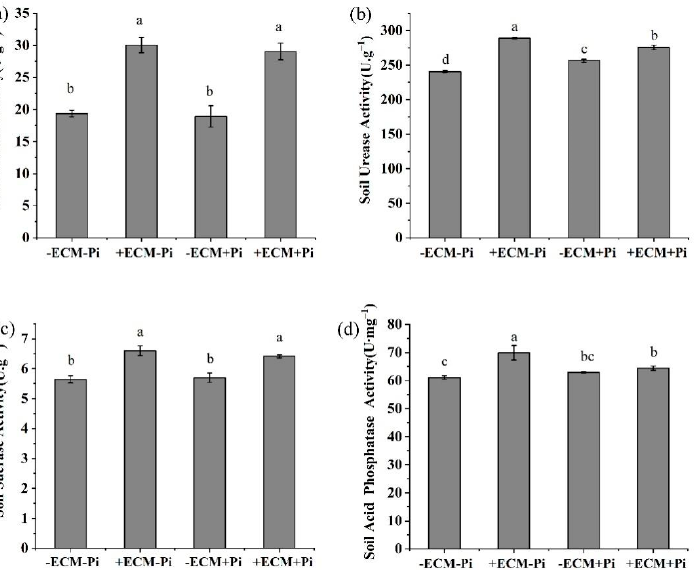
Figure 5. The effects of ECMF and Pi levels on the rhizosphere soil enzymatic activities of C. henryi seedlings. -ECM-Pi: uninoculated and low Pi; -ECM+Pi: uninoculated and high Pi; +ECM-Pi: inoculated and low Pi; +ECM+Pi: inoculated and high Pi. ( a ) Soil catalase activity; ( b ) soil urease activity; ( c ) soil sucrase activity; ( d ) soil acid phosphatase activity. The error bars refer to standard deviation. Values followed by different letters among treatments indicate significant differences ( p < 0.05).